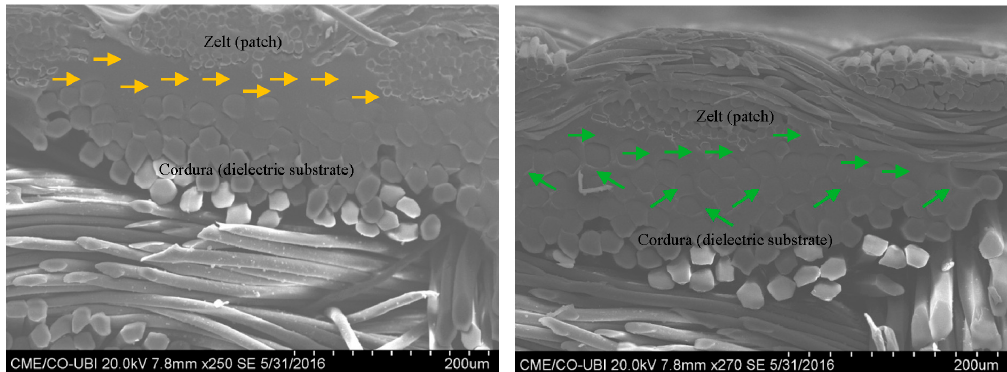
Figure 3. SEM images: cross-section of the antenna assembled ( a ) without steam and ( b ) with steam.